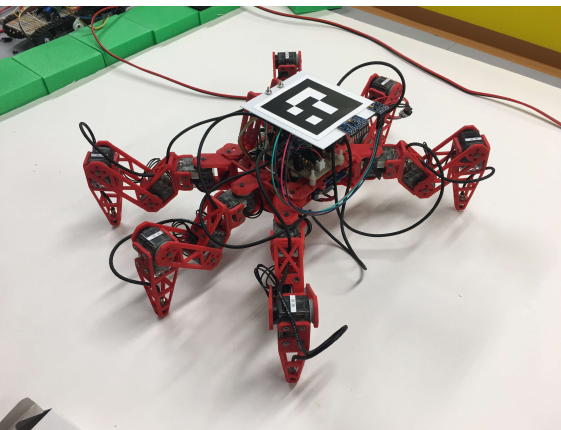
Figure 3. Actual multi-legged robot (called Robot 1). All the joints are realized using a servo motor, and the link and body structures are generated using a 3D printer. All the motors and sensors are controlled and connected using a Raspberry Pi, which is powered by a small LiPO battery. This robot also drives an external power source using a regulated DC power supply device. The servo motor used was a Dynamixel XL-320 [20], and the Python library Pypot was used to control the servo motor through the U2D2 module from the Raspberry